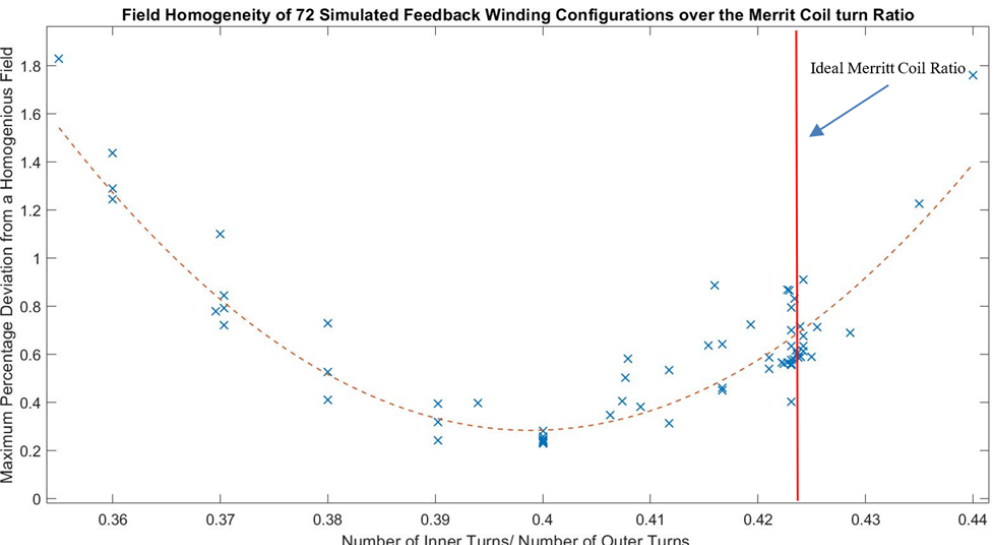
Figure 5. The percentage that the field along the racetrack core axis (at y = 12mm, between x = 15 . 7 and − 15 . 7mm) deviates from the average plotted against the ratio of inner loops of wire to outer loops. Seventy-two feedback winding configurations were simulated using the Biot–Savart model. The results of the simulation showed a relationship between the ratio of inner turns to outer turns and the homogeneity of the magnetic field. A quadratic fit with an R 2 value of 0.8 suggests that an inner- to outer-turn ratio of 0.3985 is optimal for